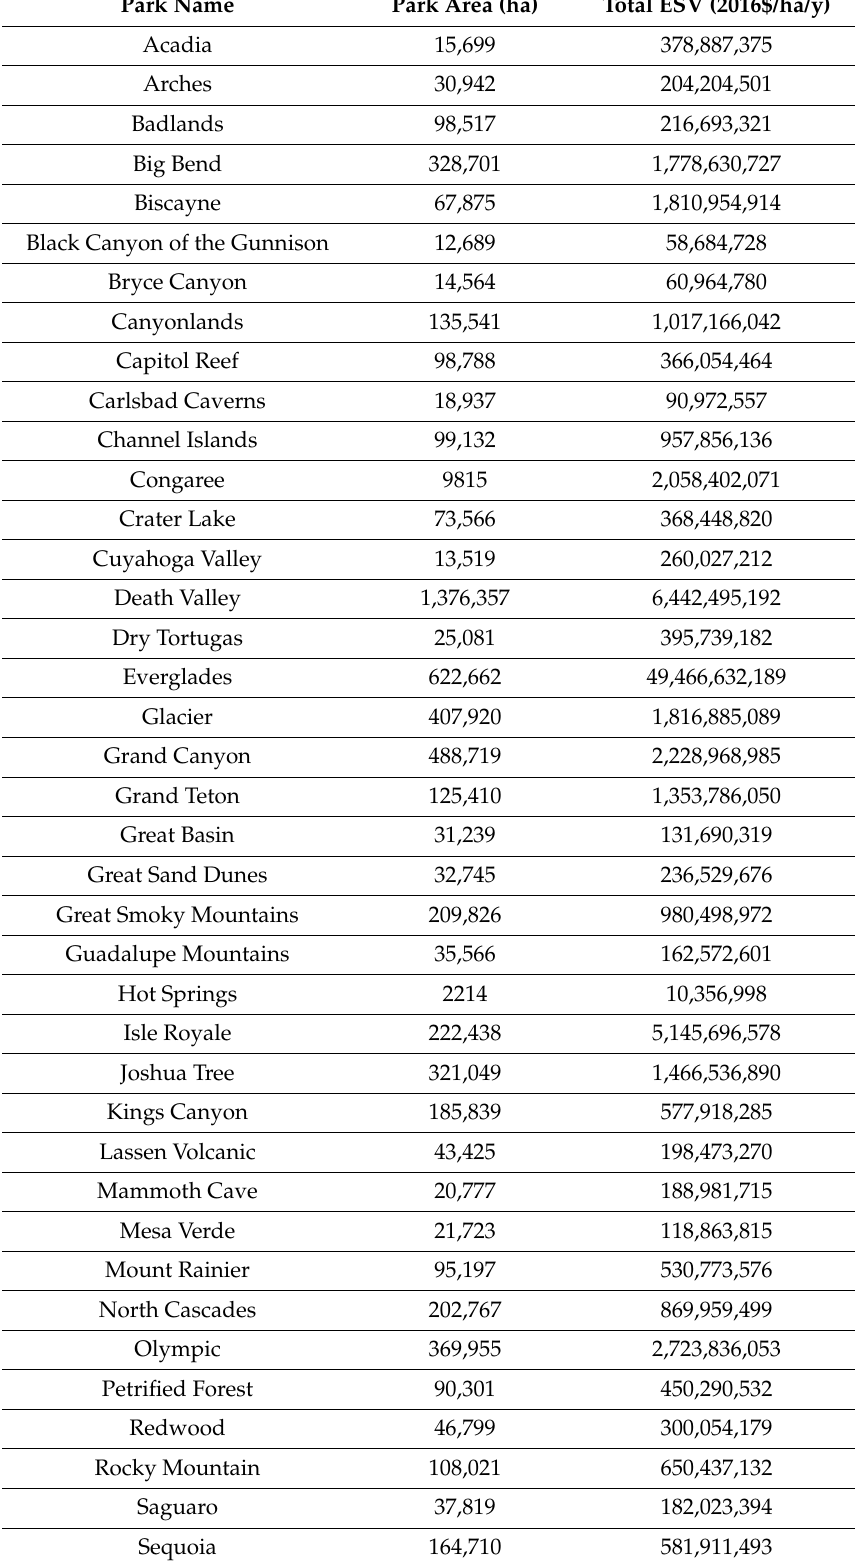
Table 1. The area and annual ecosystem service values of the National Parks in the conterminous United